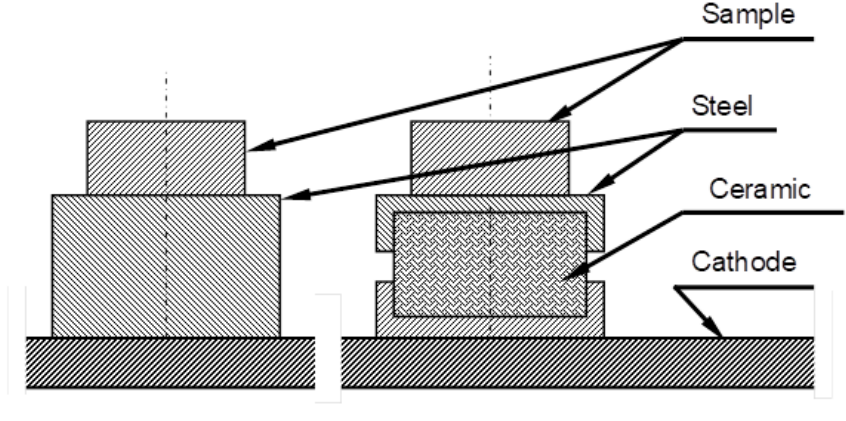
Figure 7. Positioning of test samples on the cathode. The test samples were placed on the cathode plate in two variants, either on ceramic insulators or on steel separator blocks with the size of the insulator. The separator blocks were used to eliminate any influence of sample positioning on the glow-discharge treatment process. Thermocouples for temperature measurement were installed in the holes in the side part of the sample. Measuring electrodes were installed in holes drilled on the sample surface either with direct contact with the surface or in the plasma potential at a distance of 1 mm from the sample surface. The arrangement of measuring electrodes is shown in Figure 8.